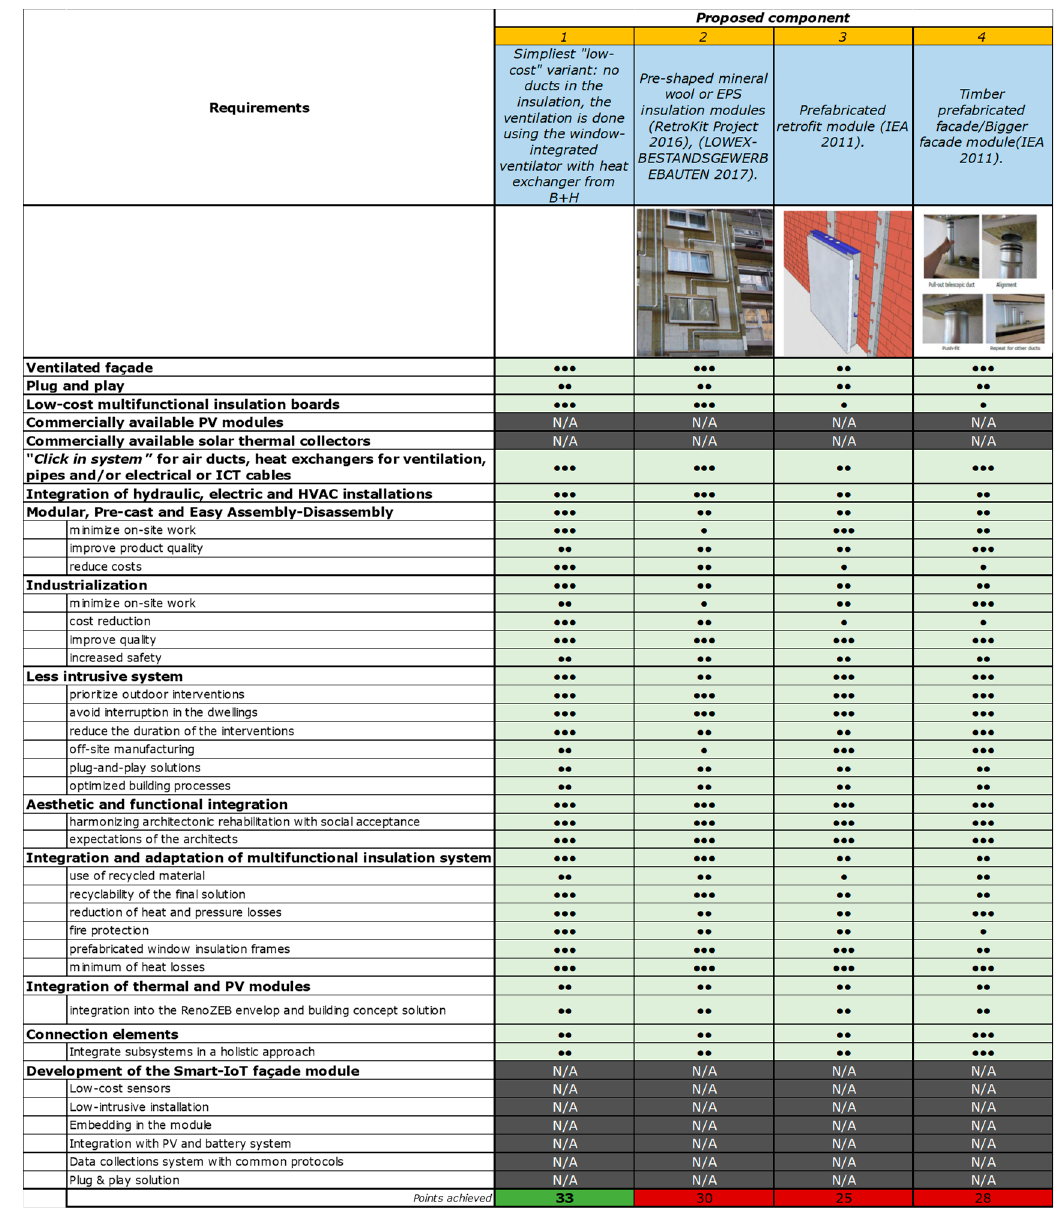
Figure 2. MCDM for multifunctional insulation